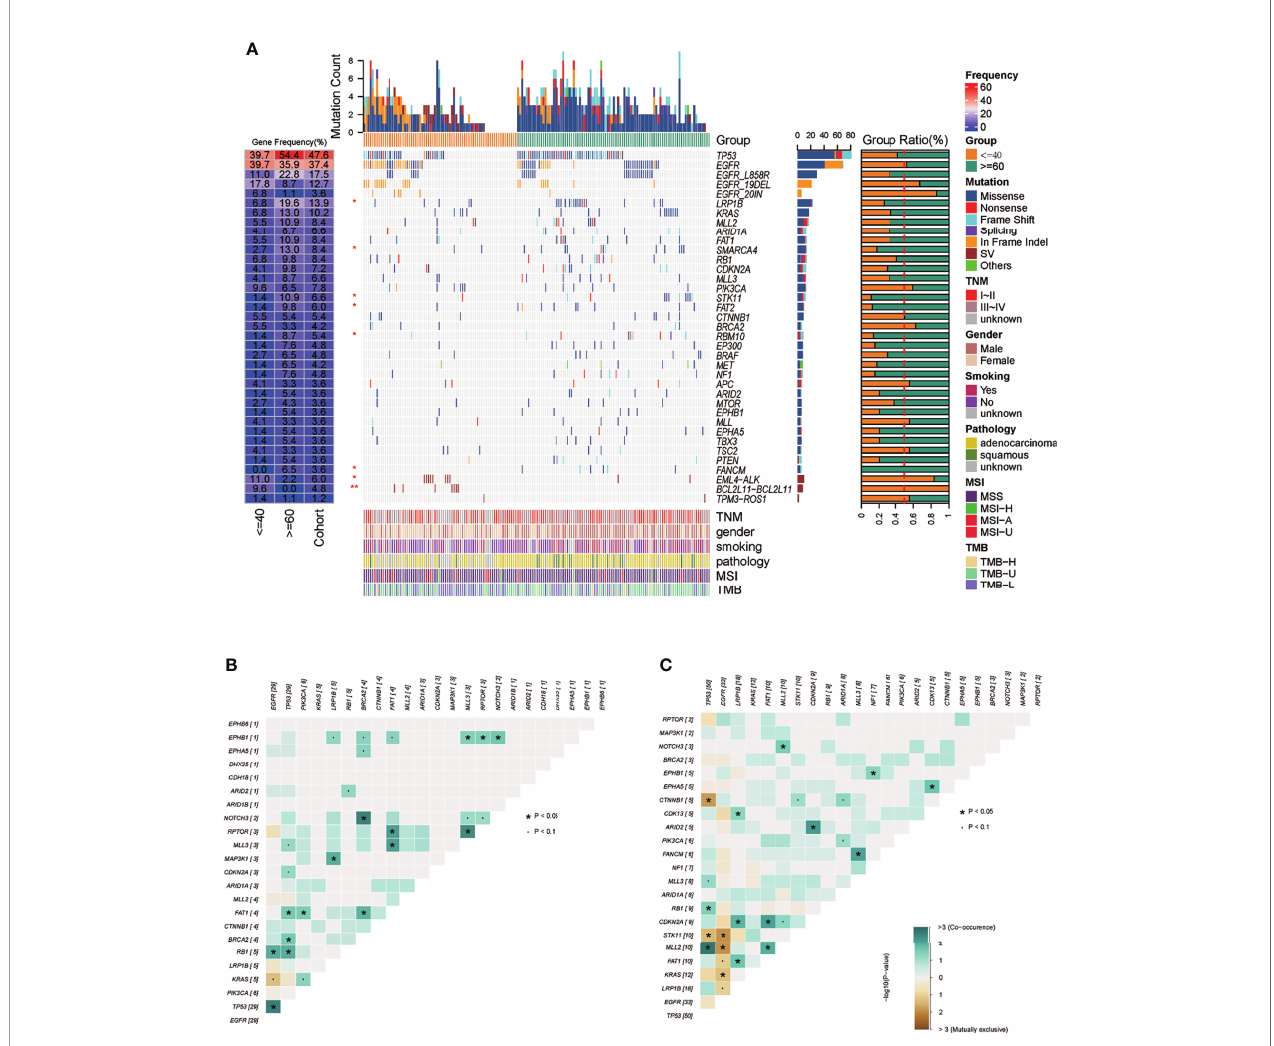
FIGURE 3 | Mutation landscape of the 165-sample cohort. (A) Mutation spectrum of young and old lung cancer groups in the 165-sample cohort. (B) The mutually concurrent and exclusive genes in the young lung cancer group. (C) The mutually concurrent and exclusive genes in the old lung cancer group. "*" means the p value < =